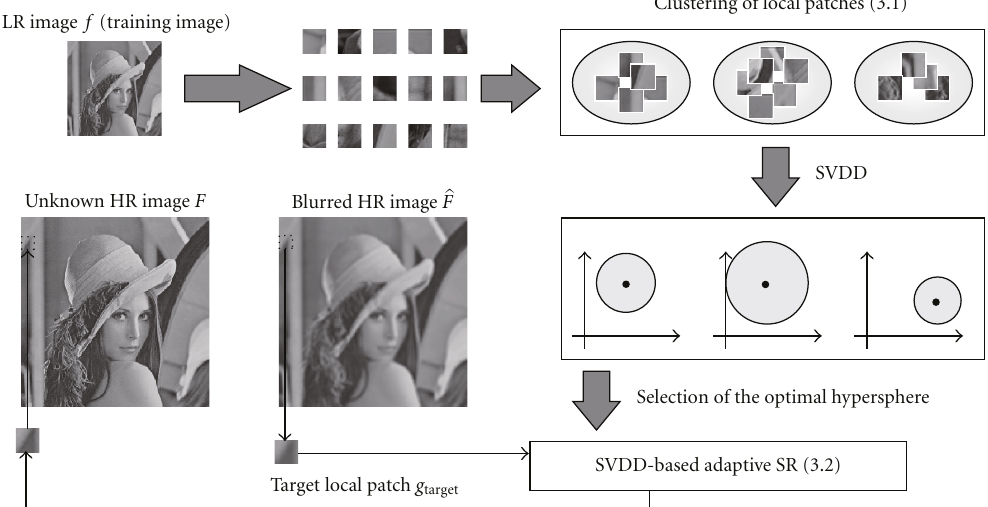
Figure 1: Relationship between HR image F , blurred HR image (cid:3) F , and LR image f .